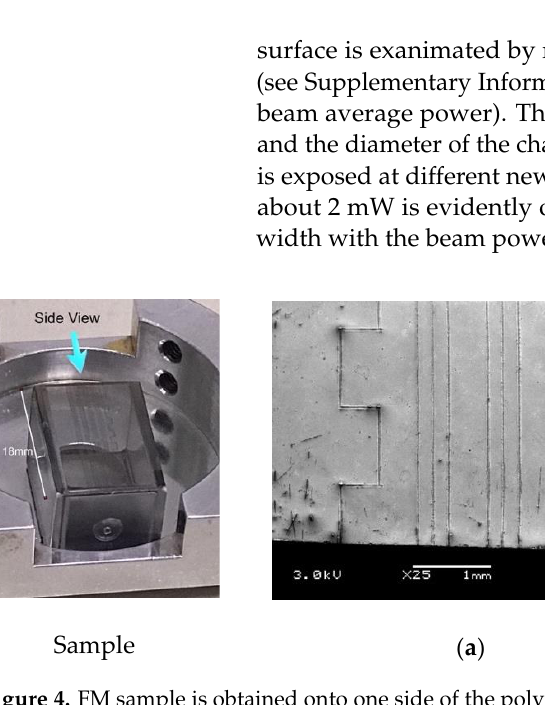
Figure 4. FM sample is obtained onto one side of the polystyrene spectrophotometer cuvette of 10 × 18 mm 2 , using a speed of 0.02 mm s − 1 , and average power of 9.3 ± 0.1 mW, focused on a plane coincident with the ablated surface (Z = 0). The ( a ) shows a scanning electron microscope image of a top view of a polystyrene (PS) cuvette for conventional spectroscopic use. ( b ) Scanning cross-section image of an 18 mm long microchannel.